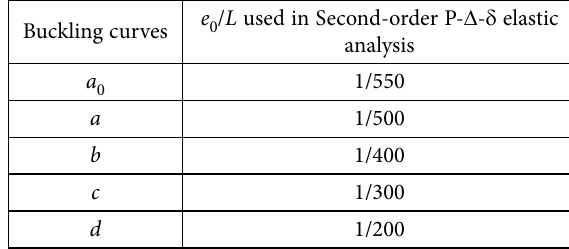
Table 3. Values of member initial bow imperfection Buckling curves